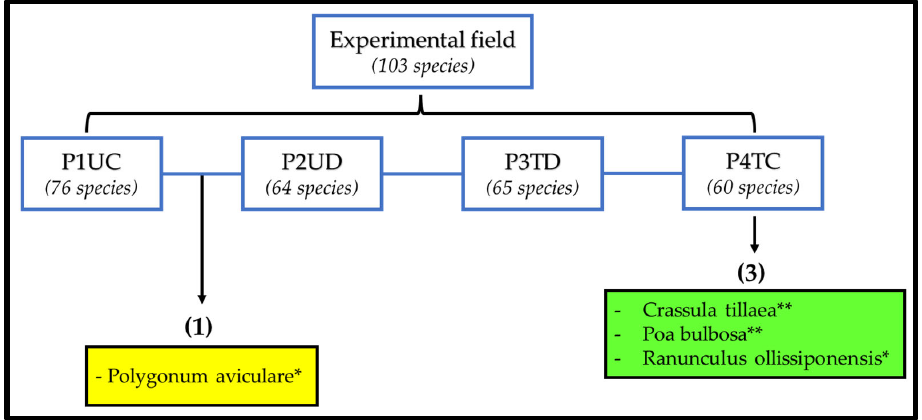
Figure 10. Representative diagram of the analysis of indicator species (ISA), for each plot (P1UC, P2UD, P3TD and P4TC) and their combinations. **—Probability < 0.01; *—Probability < 0.05.